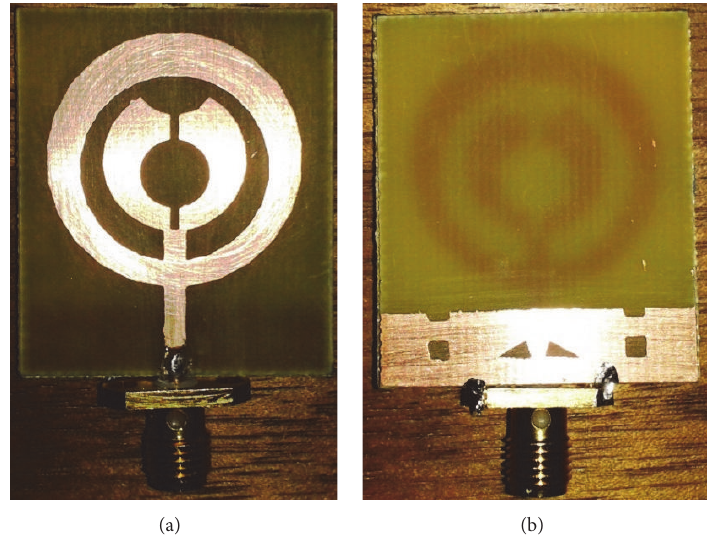
Figure 30: Fabricated prototype of [100]. (a) Top view. (b) Bottom view.